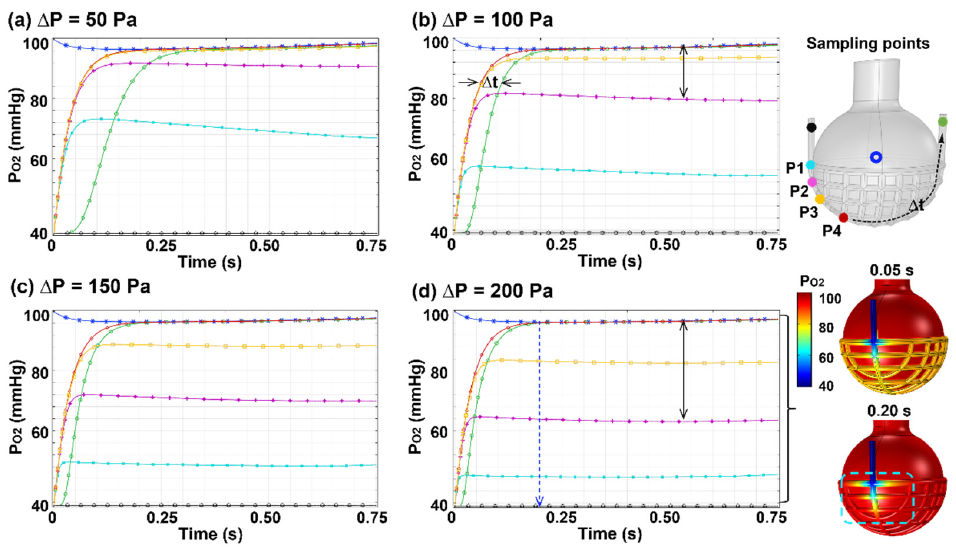
Figure 10. Effects of the perfusion rate on temporal–spatial oxygen exchange by varying the capillary pressure ∆ P: ( a ) 50 Pa, ( b ) 100 Pa, ( c ) 150 Pa, and ( d ) 200 Pa. D m = 2.0 × 10 − 10 m 2 /s.